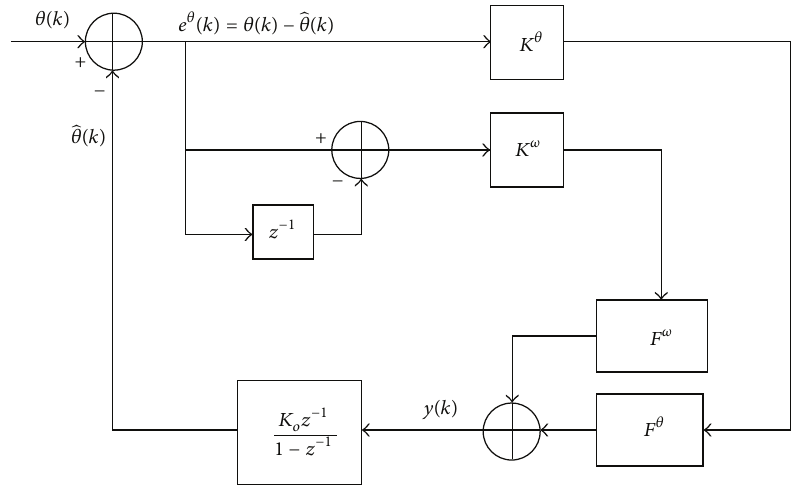
Figure 1: Structure of the third-order PLL assisted second-order FLL.